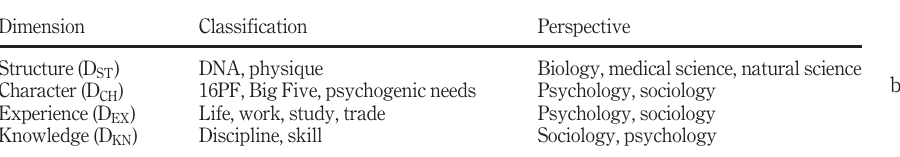
Table II. Dimensions of the